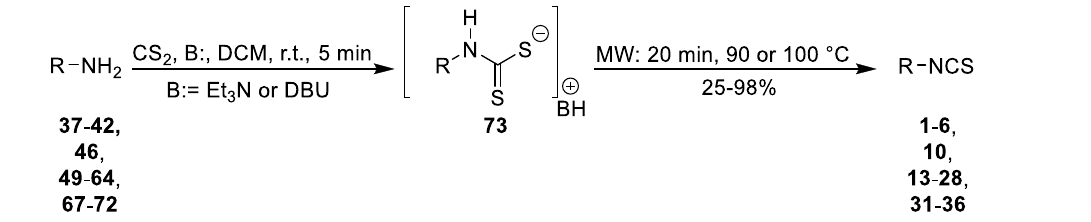
Scheme 1. Method A: microwave-assisted synthesis of isothiocyanates 1 – 6 , 10 , 13 – 28 , and 31 – 36 .